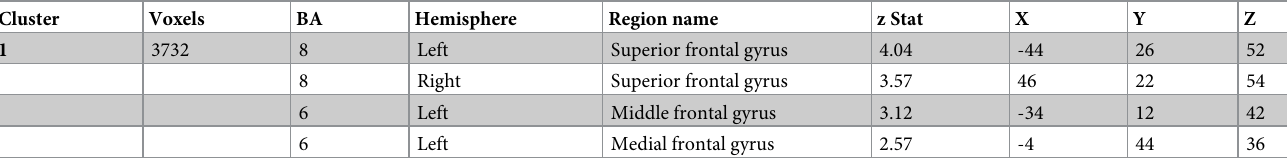
Table 4. Activation peaks for regions showing proportionate SME for TD for items retrieved 1 week later. Cluster Voxels